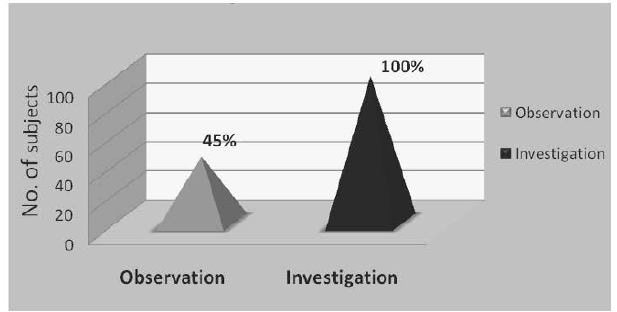
Figure 2: showing the percentages of subjects not looking through the optical centers of their lenses as observed and meas-